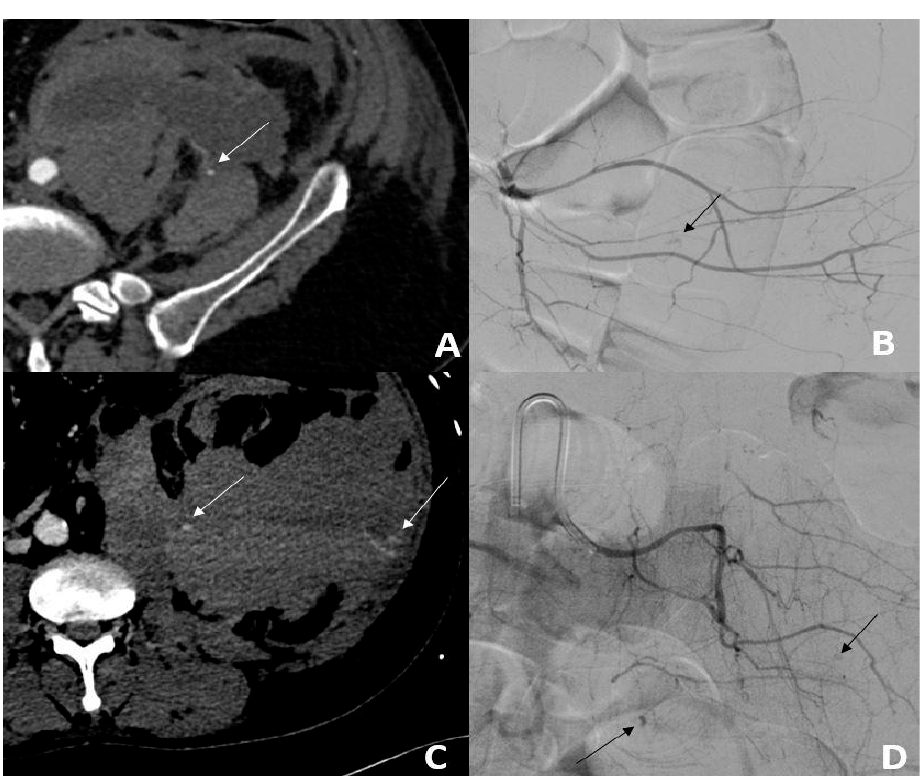
Figure 3. Back pain in a 45-year-old patient hospitalized for Sars-cov2 infection and pulmonary embolism. ( A ) The MDCT scan showed active bleeding (white arrow) from a large left retroperitoneal hematoma. ( B ) Angiography confirmed active unifocal bleeding (black arrow) from the left L5 lumbar artery, treated with gelatine sponge ( C ). On day 1, the patient presented with persistent blood loss. The MDCT scan showed a persistent hematoma with active bleeding (white arrows). ( D ) Angiography showed new multifocal active bleeding (black arrows) treated using 1 coil.